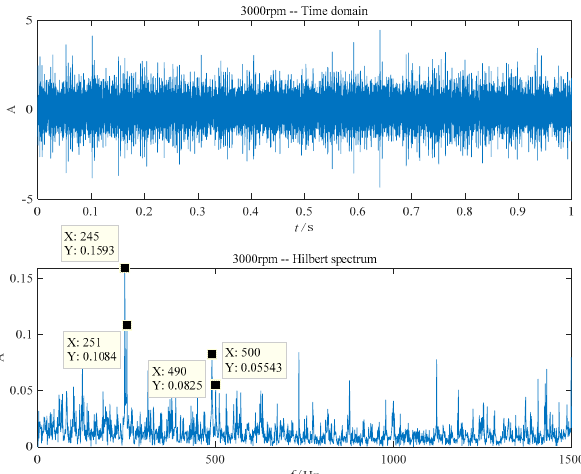
Figure 4. The ball–inner ring scratching fault. ( a ) The time domain waveform; ( b ) envelope detection based on improved EEMD.